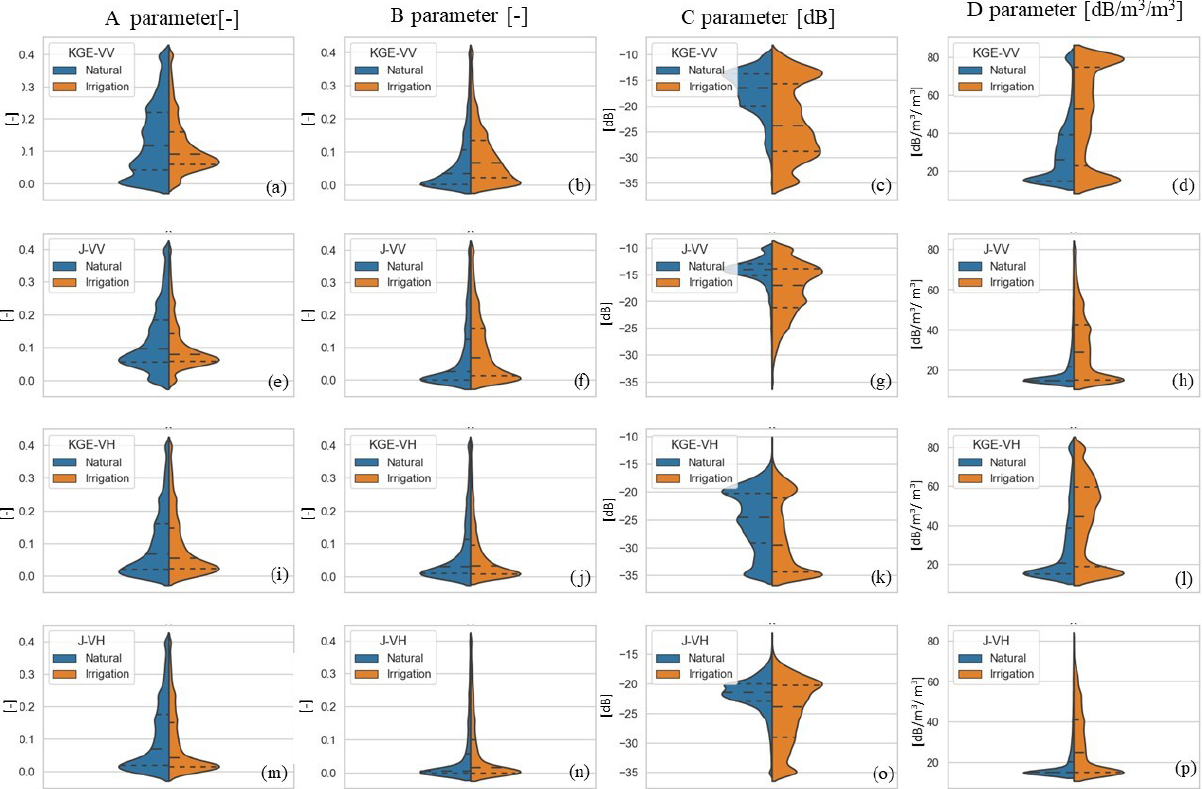
Figure 8. Split violin distributions of the calibrated parameters over the entire study area for the eight calibration experiments. For both the natural (blue) and irrigation (orange) experiments, the distributions are shown for the A , B , C , and D parameters, (a–d) using the KGE objective function for VV polarization, (e–h) J objective function for VV polarization, (i–l) KGE objective function for VH polarization, and (m–p) J objective function for VH polarization. Note that the areas under the histograms on both left and right sides of the violins are automatically scaled for optimizing the visualization.